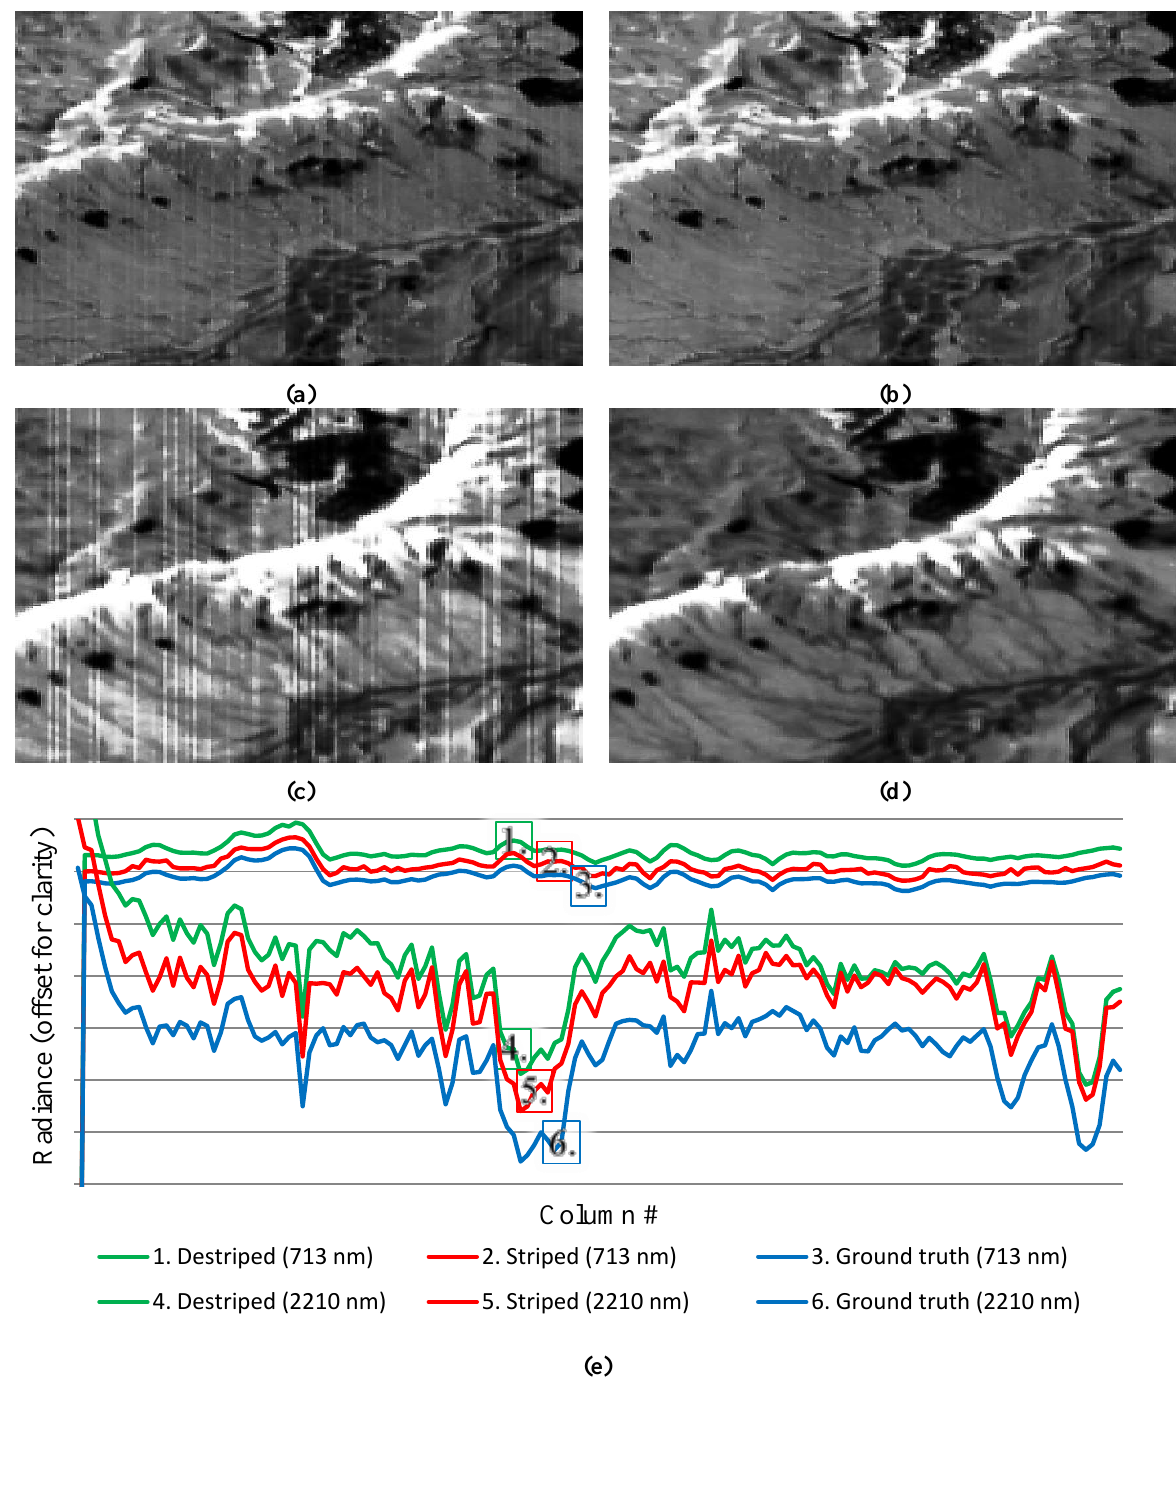
Figure 8. Exemplary grey scaled, striped images of sections in the middle of a EnMAP scene (VNIR-band 53–713 nm ( a ), SWIR-band 214–2210 nm ( c ) and their respective radiometrically recalibrated results (VNIR – ( b ), SWIR – ( d )) as well as a transect plot ( e ) through the middle of the same section for same VNIR and SWIR